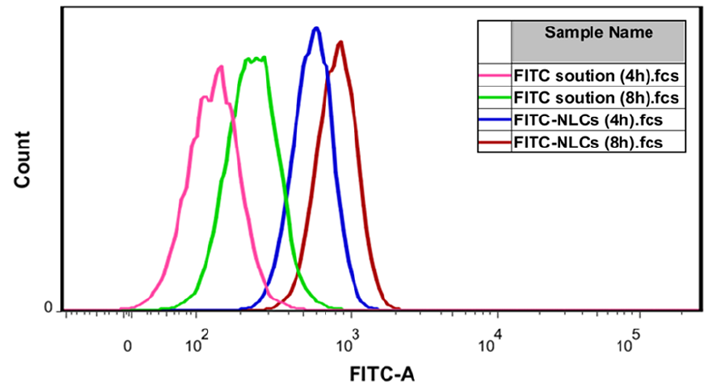
Figure 10. FITC intensity in B16F10 cells treated with solution or NLCs.